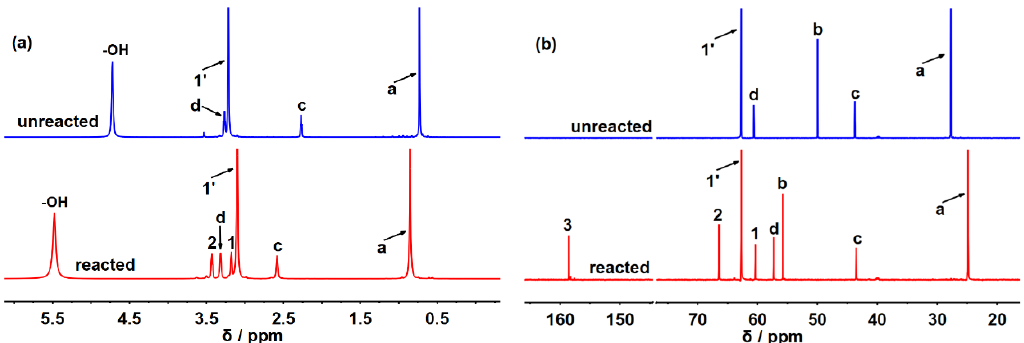
Figure 1. NMR spectra of TBAE-EG system before and after CO 2 absorption: ( a ) 1 H NMR; ( b ) 13 C NMR.